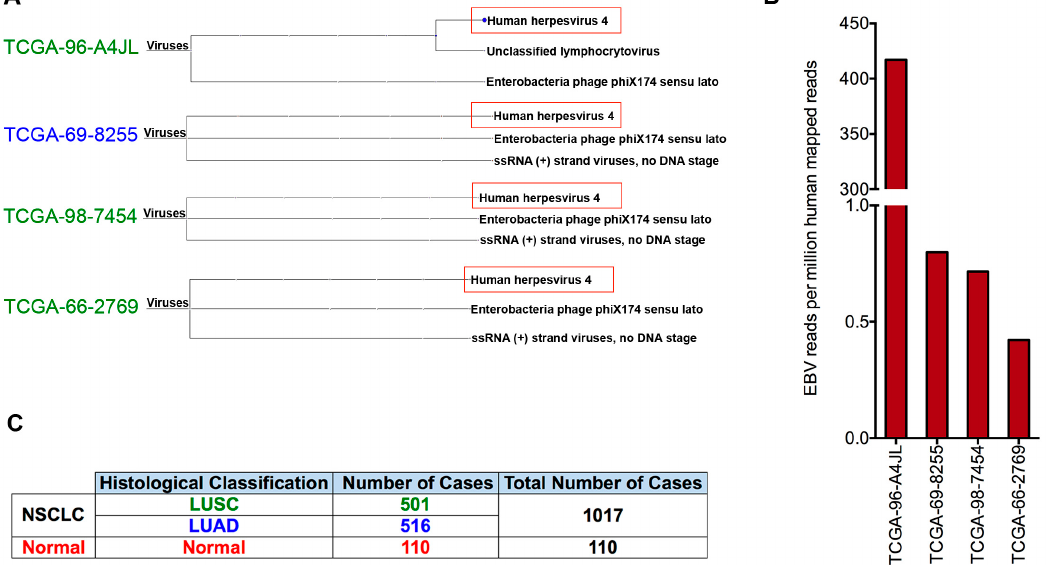
Figure 2. Detection of EBV in non-small cell lung cancer data sets. ( A ) Approximately 20 million of randomly selected RNA-seq reads from each of 1127 non-small cell lung cancer samples and tumor-adjacent normal lung tissue samples were analyzed using the RNA CoMPASS software. The virome branch of the taxonomy trees for the four EBV positive samples was generated using the metagenome analysis tool, MEGAN 4. ( B ) For more in-depth analyses of EBV reads, the entire sequence read file for each sample (~60–118 million reads) was aligned to the modified Akata-EBV genome and the hg38 human genome assembly using the STAR aligner. Of the EBV(+) samples, one sample (EBV-high) was identified as having high numbers of EBV reads, while three (EBV-low) were found to have low but detectable numbers of EBV reads. ( C ) Histology types of analyzed lung cancer specimens.